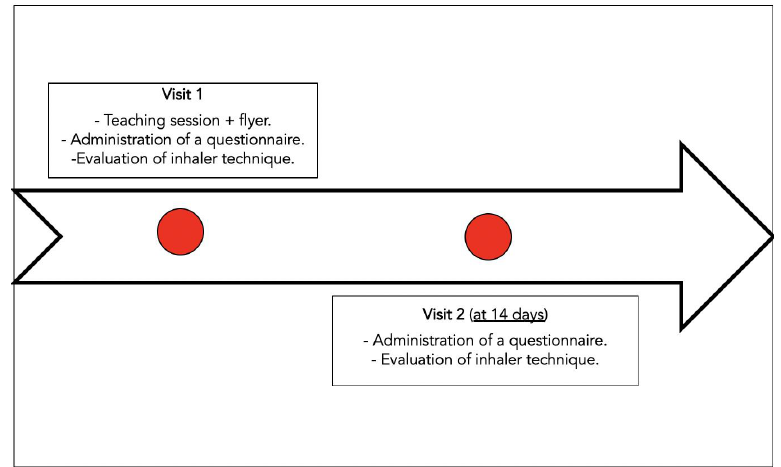
Figure 1. Study design and visit schedule.